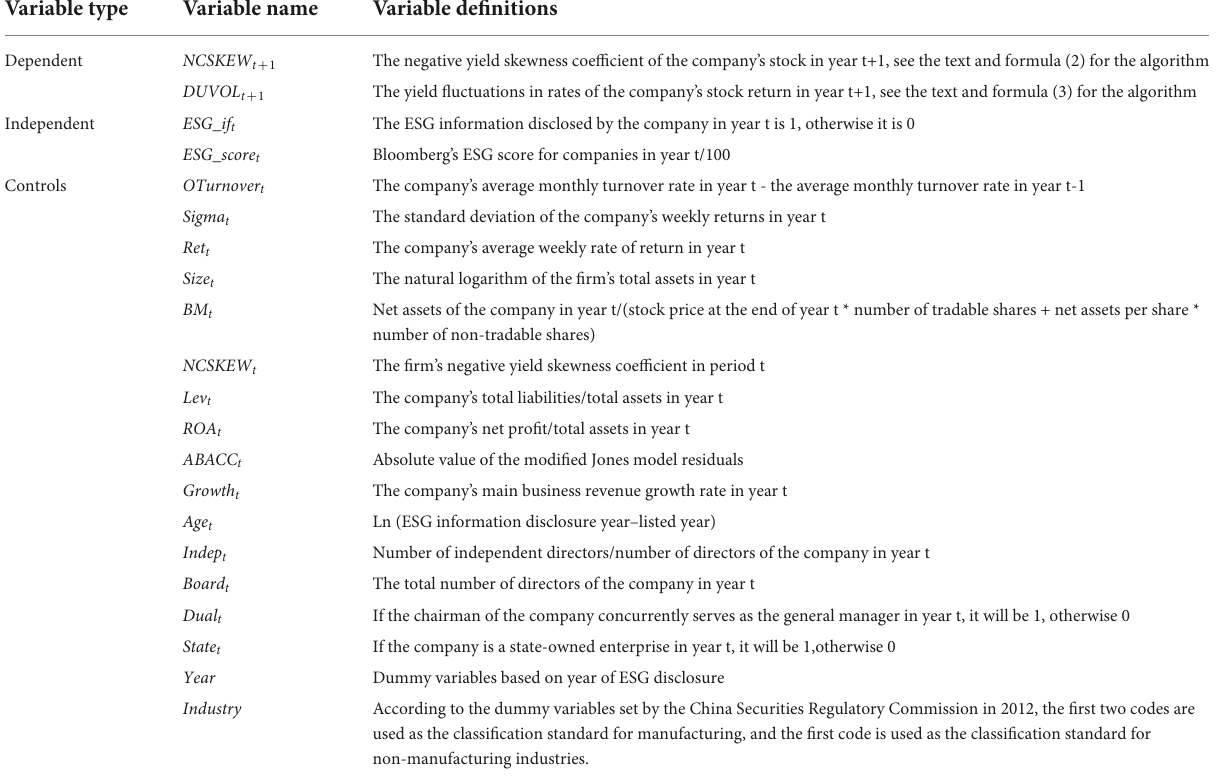
TABLE A1 Variable